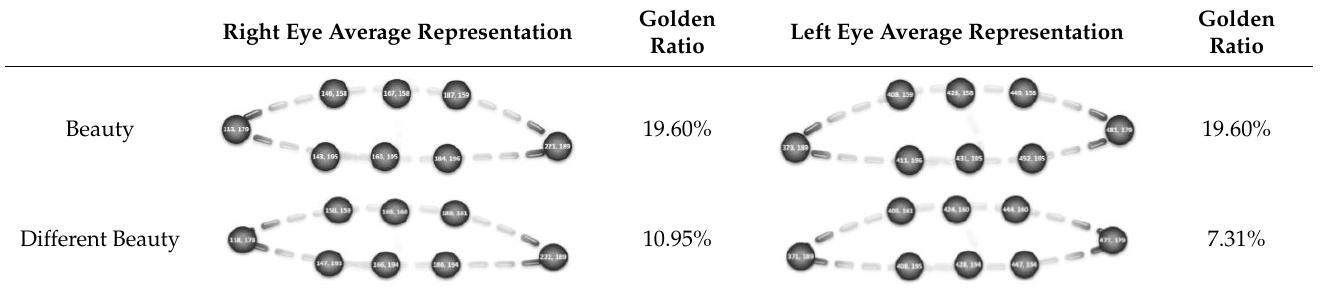
Table 9. Beauty class average eye golden ratio of 10 participants.